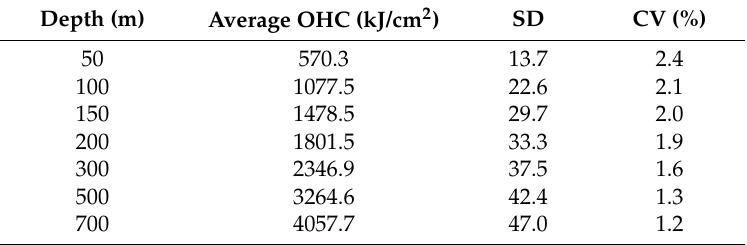
Table 1. Average, standard deviation (SD), and coefficient of variation (CV) of the ocean heat